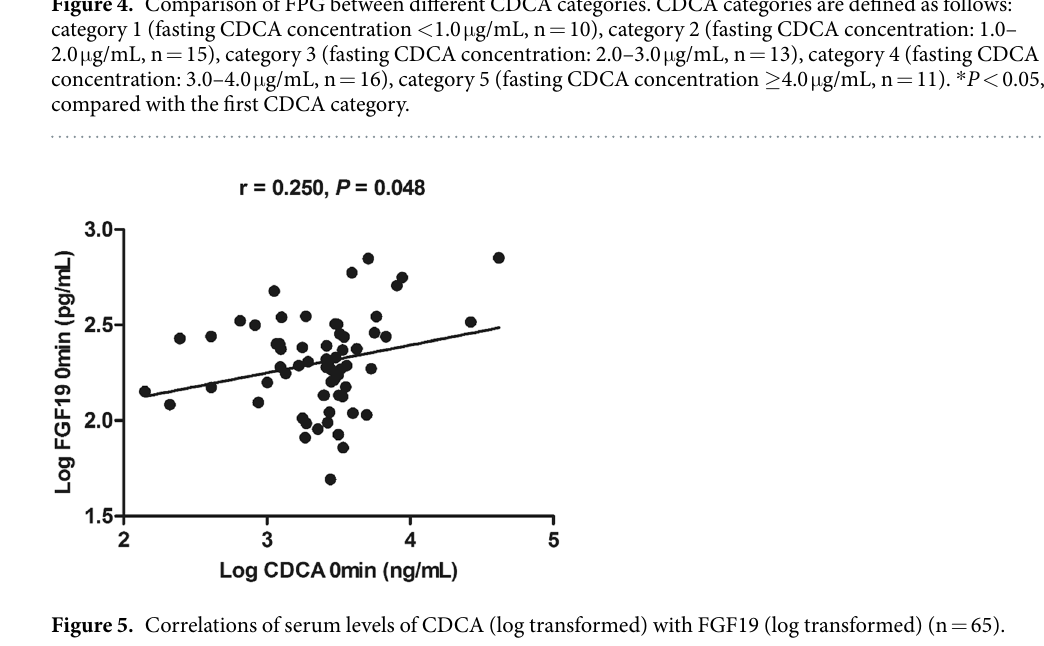
Figure 5. Correlations of serum levels of CDCA (log transformed) with FGF19 (log transformed) (n =